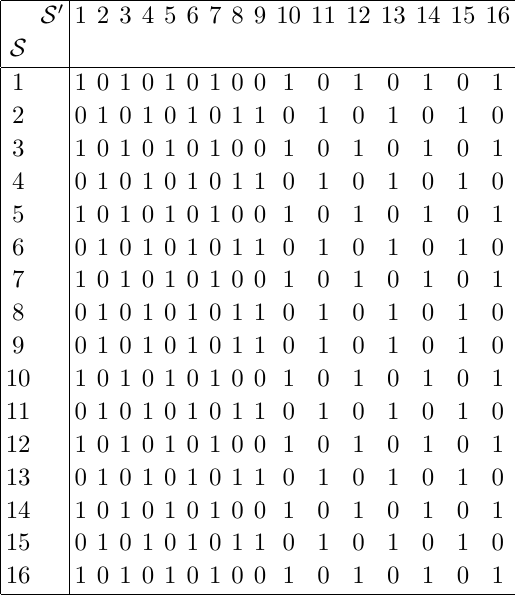
(cid:2) P with di(cid:11)erent boolean factors. [1] [5]